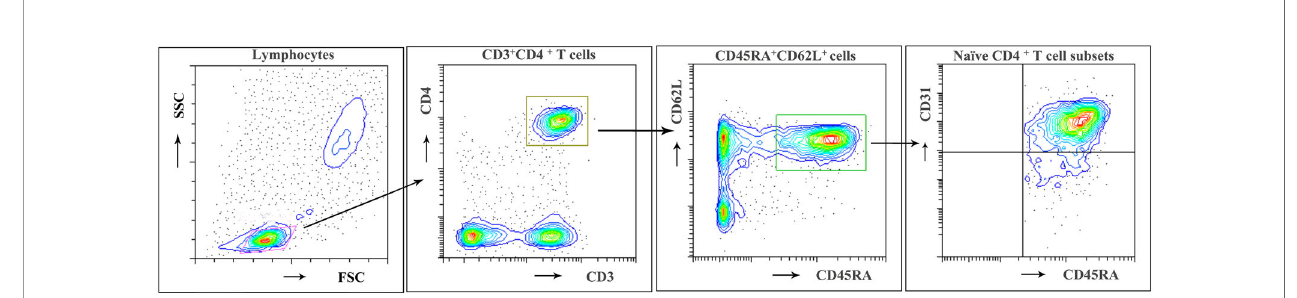
FIGURE 1 | Flow cytometric identi fi cation of naïve CD4 + T cell subpopulations. A representative analysis of CD31 + thymic naive and CD31 - central naive CD4 + T cells as described in Materials and Methods is depicted. First lymphocytes were identi fi ed according to FSC/SSC characteristics. Then CD3 + CD4 + cells were gated and subdivided according to CD62L and CD45RA expression. Among CD62L + and CD45RA + naive CD4 + T cells, the frequency of CD31 + thymic naive and CD31 − central naive CD4 + T cells was determined. Representative results of a 21-year-old woman from the HC